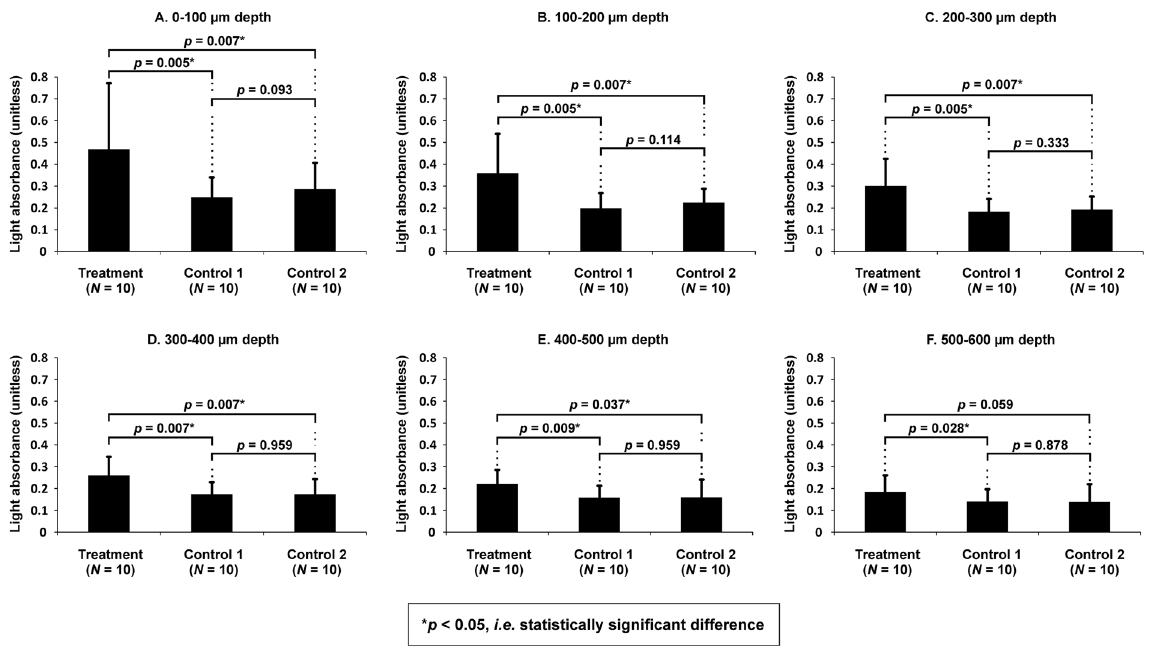
Figure 4. Depth-wise optical absorbance (mean ± 95% CI) in different sample groups. Absorbance, representing methylene blue (MB) content, was statistically significantly greater up to a depth of 400–500 µ m in T1 (ultrasound exposure during MB immersion) compared to C1 (ultrasound exposure in PBS followed by MB immersion). Absorbance was greater in T1 up to a depth of 500–600 µ m compared to C2 (no ultrasound treatment, only MB immersion). No significant (p > 0.05; Friedman followed by Wilcoxon) difference between groups was observed at depths > 600 µ m from AC surface. The result suggests that laser-ultrasound can deliver MB into